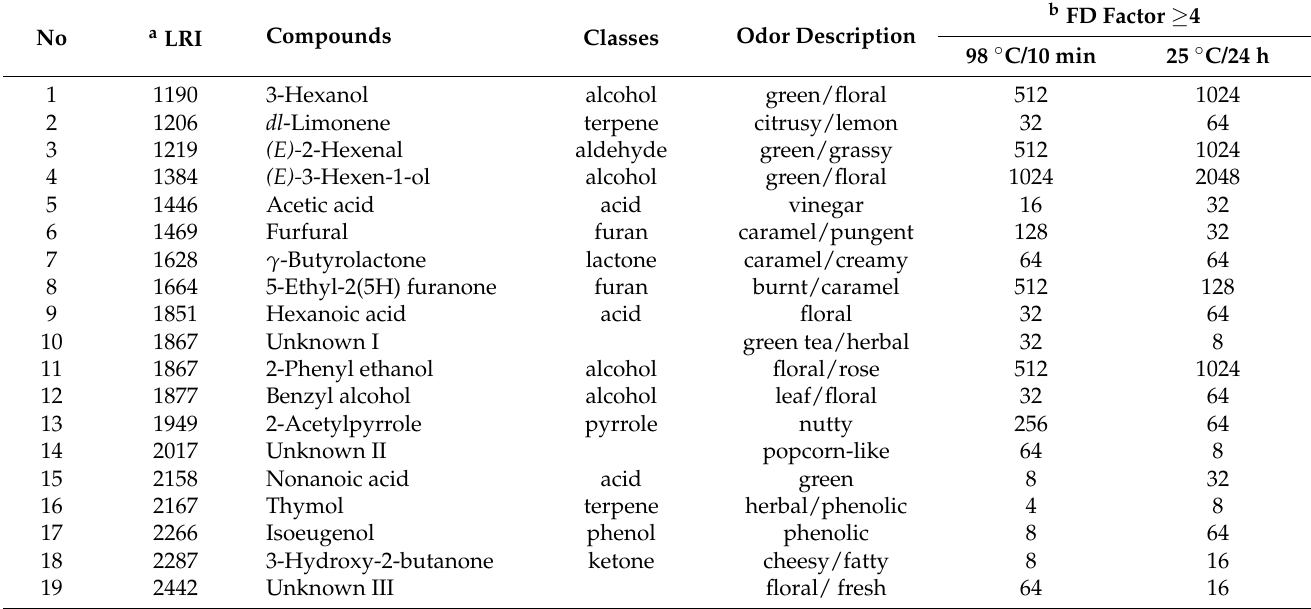
Table 3. Key odorants of Moringa herbal tea obtained from two brewing processes.